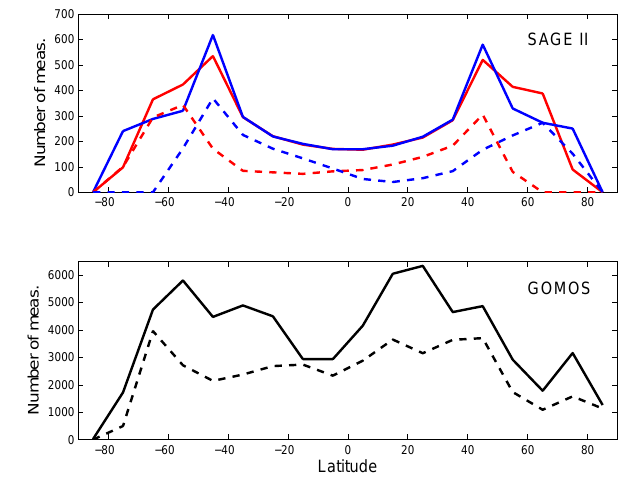
Fig. 1. The number of SAGE II sunrise (red) /sunset (blue) measure- ments for 1984–2005 and GOMOS nighttime measurements (black) for 2002–2011.